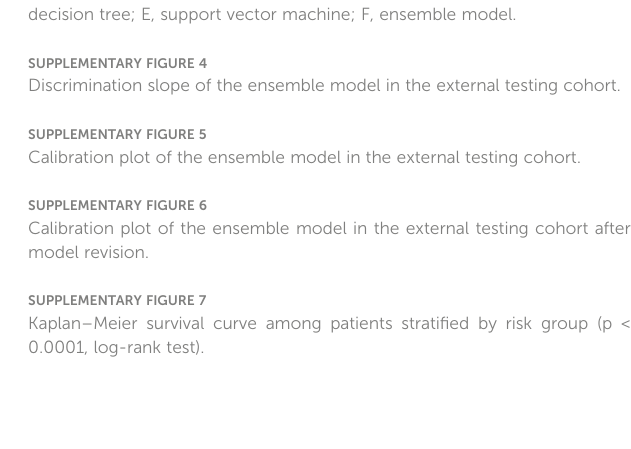
SUPPLEMENTARY FIGURE 1 The receiver operating characteristic curve for the ensemble model in the external testing cohort. SUPPLEMENTARY FIGURE 2 Density cure for the ensemble model in the external testing cohort.